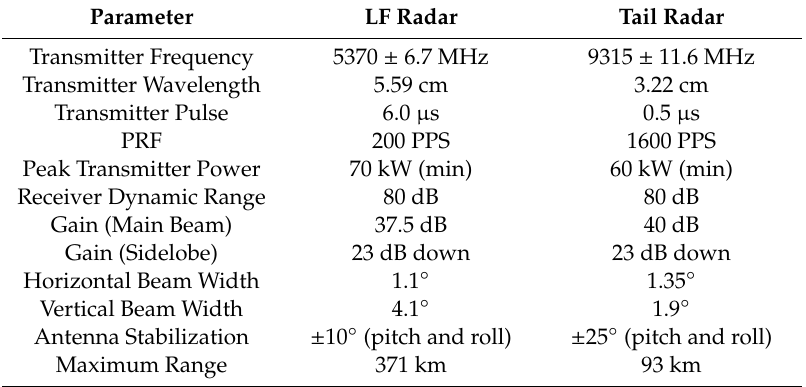
Table 1. Airborne radar parameters for the lower fuselage (LF) and tail radar systems aboard WP-3D flights